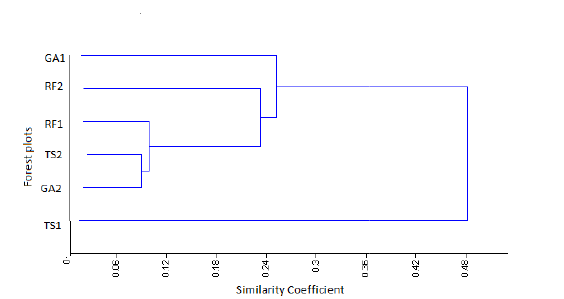
Fig. 2. Family dominance of plant species in the three study sites in Shasha Forest reserve